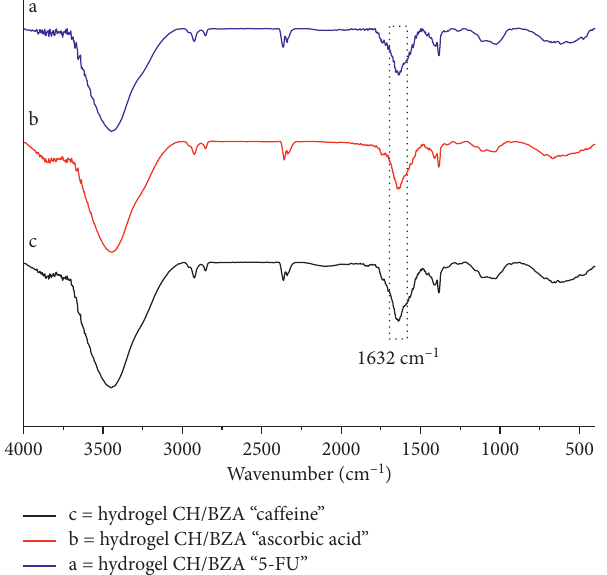
Figure 11: FTIR spectra of drug loaded into a physical